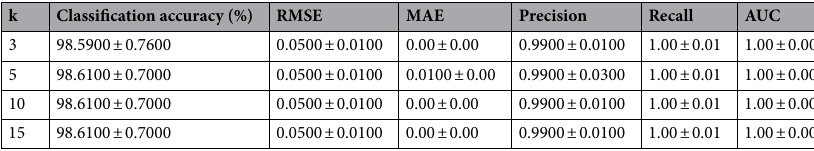
Table 7. Mean values and standard deviation of model performances on the female